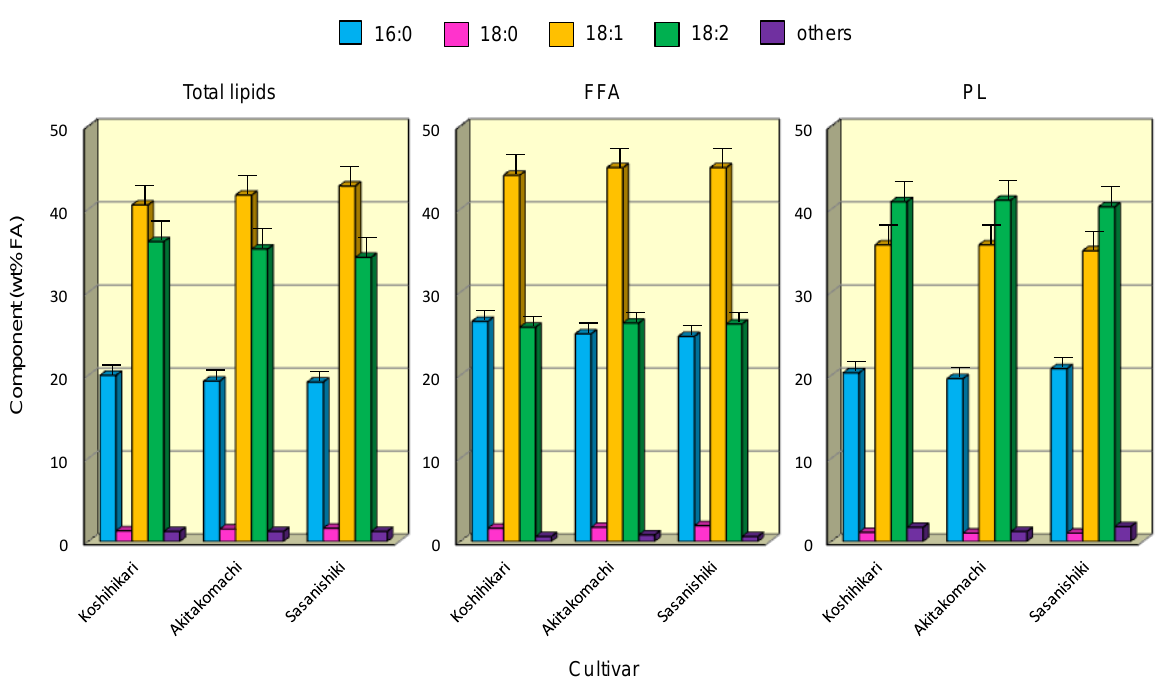
Figure 3. FA distribution in total lipids (left panel), FFA (middle) and PL (right) prepared from rice brans. Each value represents the average of three determinations, and vertical bars depict the mean and standard deviation. “Others” include minor FA such as 14:0, 16:1, 18:3 and 20:0. For abbreviations, see Figure 1.